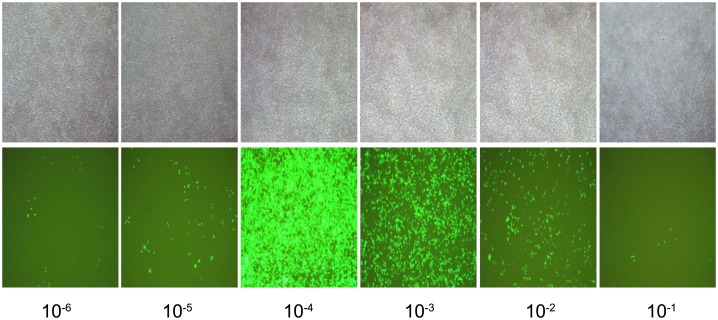
Fluorescence detection in 293T cells at 48 h after plasmid transfection.Note: the experiment was repeated 3 times, and means were obtained.